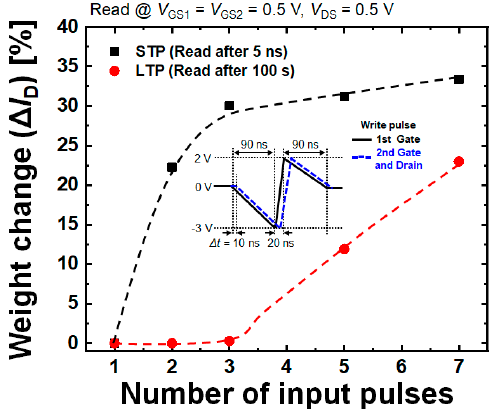
Figure 10. Variation in threshold voltage by the potentiated or depressed SFG. After two pulses are fed with time difference (pre- and post-input signals), potentiation and depression take place under the conditions of Δ t > 0 and Δ t < 0, respectively. The shorter time interval between the pre-and post-input signals, the larger becomes the variation in the threshold voltage.